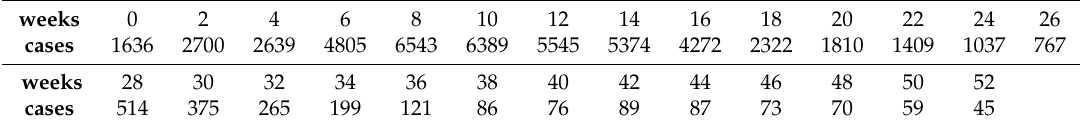
Table A2. Biweekly reported measles infections in 1961 in London, UK